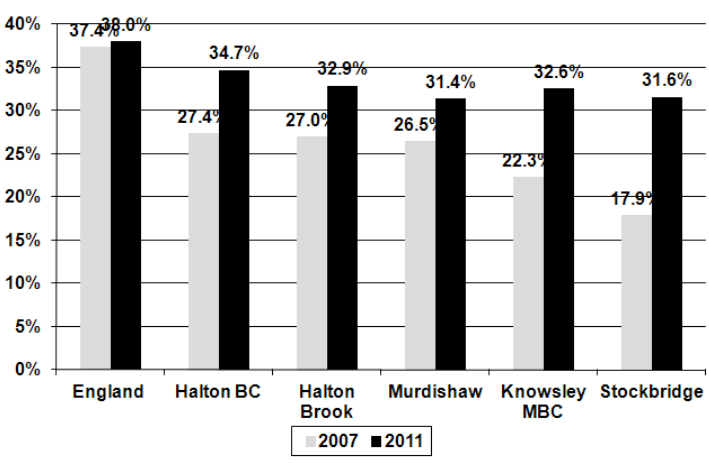
Figure 1. Election